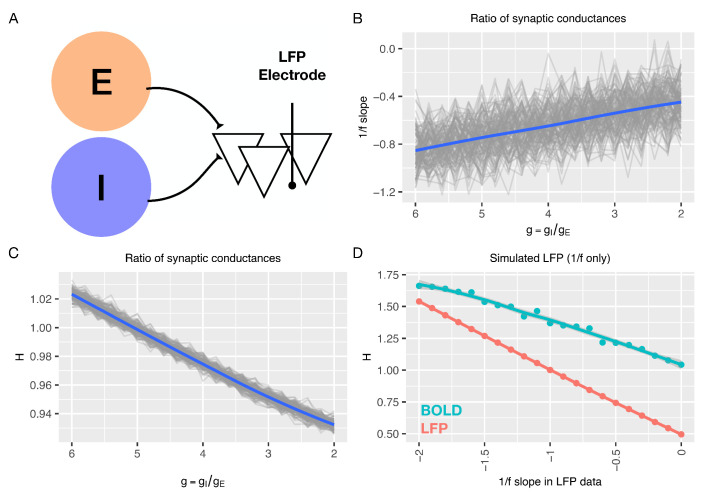
In silico predictions from a non-recurrent model of how 1/f slope and H change with E:I ratio (g).Panel A shows a schematic of the model (Gao et al., 2017) that computationally generates LFPs based on manipulated E:I ratios. For parameters utilized in this model, see Supplementary file 1. Panel B reproduces the relationship reported in Gao et al., between 1/f slope and E:I ratio. All 128 simulated channels are shown in gray, and their average is shown in blue. Panel C shows the relationship between H and E:I ratio from the Gao et al., model. Panel D shows H computed on simulated LFP where the 1/f slope is prespecified. H computed on LFP data is shown in pink. The simulated BOLD signal (simulated in the same way as data from the recurrent model) is plotted in cyan.